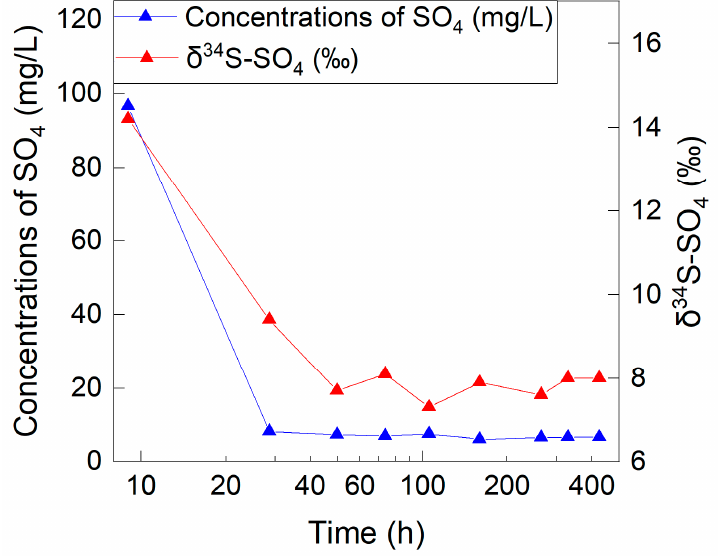
Figure 2. Change in concentrations of SO 4 and δ 34 S-SO 4 in the effluent water over time. The δ 34 S-SO 4 values of the effluent water samples ranged from 7.3‰ to 14.2‰, while the δ 18 O-SO 4 values ranged from − 2.0‰ to 5.9‰ (Figure 3). The δ 34 S-SO 4 changed from 14.2‰ to 8.0‰, and the δ 18 O-SO 4 changed from 5.9‰ to − 1.9‰ from the beginning to the end of the experiment.